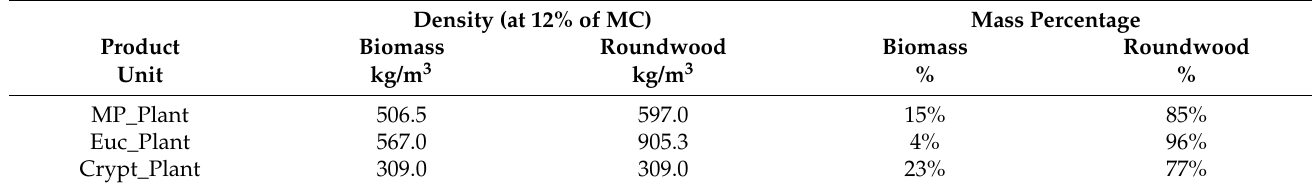
Table 7. Calculation of percentages of mass